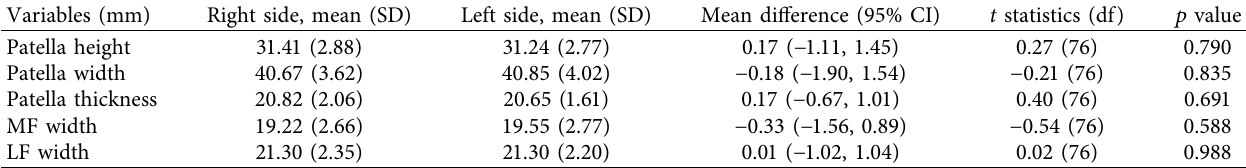
Table 2: Comparison of patella dimensions between the right and left side ( n � 156).